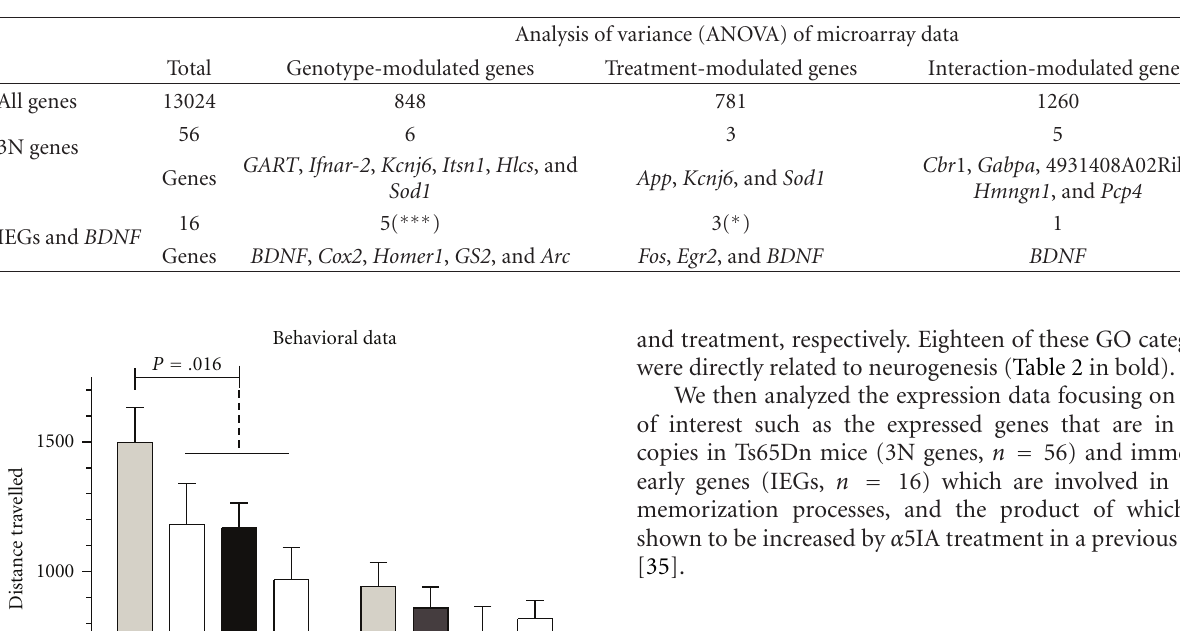
Table 1: Analysis of variance (ANOVA) of microarray data: genotype (Euploids versus Ts65Dn mice) and treatment (Vehicle versus α 5IA- treated) were the two main factors. Three-copy genes and IEGs were analyzed separately.